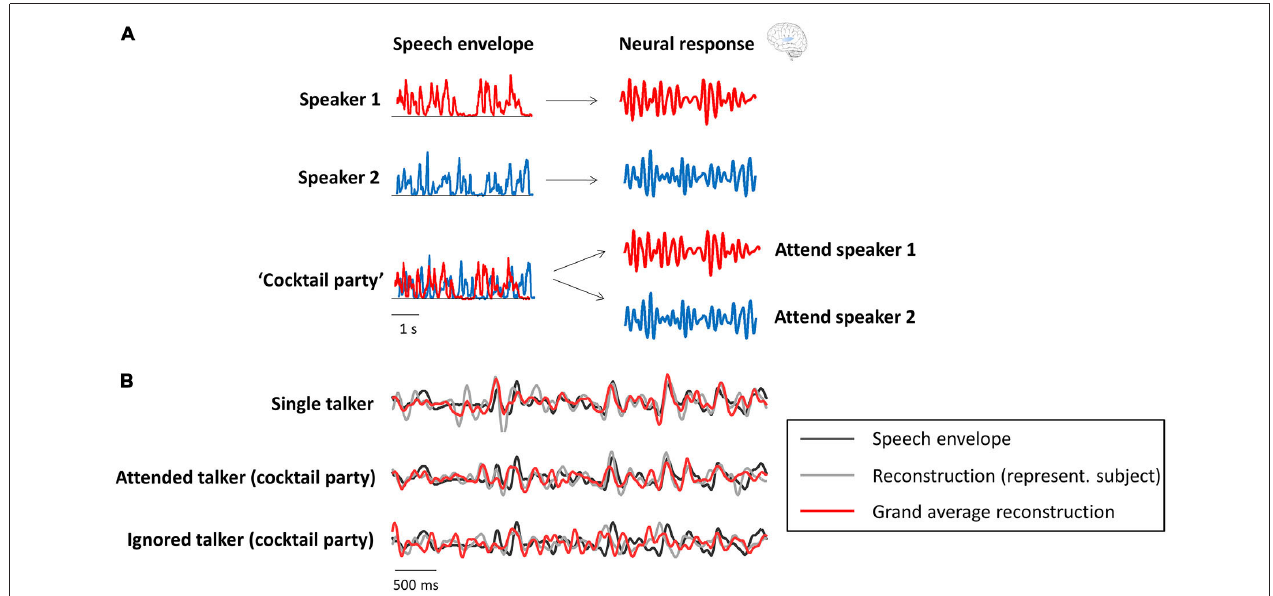
FIGURE 2 | Neural oscillations as a tool for attentional selection during a “cocktail party”. (A) Theoretical background (modified with permission from Zion Golumbic et al., 2012, copyright Elsevier). Recorded neural activity in the delta/theta band (right column) aligns with the speech envelope (left column) of the respective speaker (red and blue), when presented separately. In a multi-speaker scenario (“cocktail party”), the recorded data will reflect the attended, but not necessarily (or to a smaller degree) the unattended speech envelope. (B) Actual data (modified with permission from Zion Golumbic et al., 2013b, copyright Elsevier) confirms the theoretical background. The speech envelope reconstructed from the recorded data (gray: single subject; red: averaged across subjects) strongly resembles the speech envelope (black) of the attended, but not the unattended